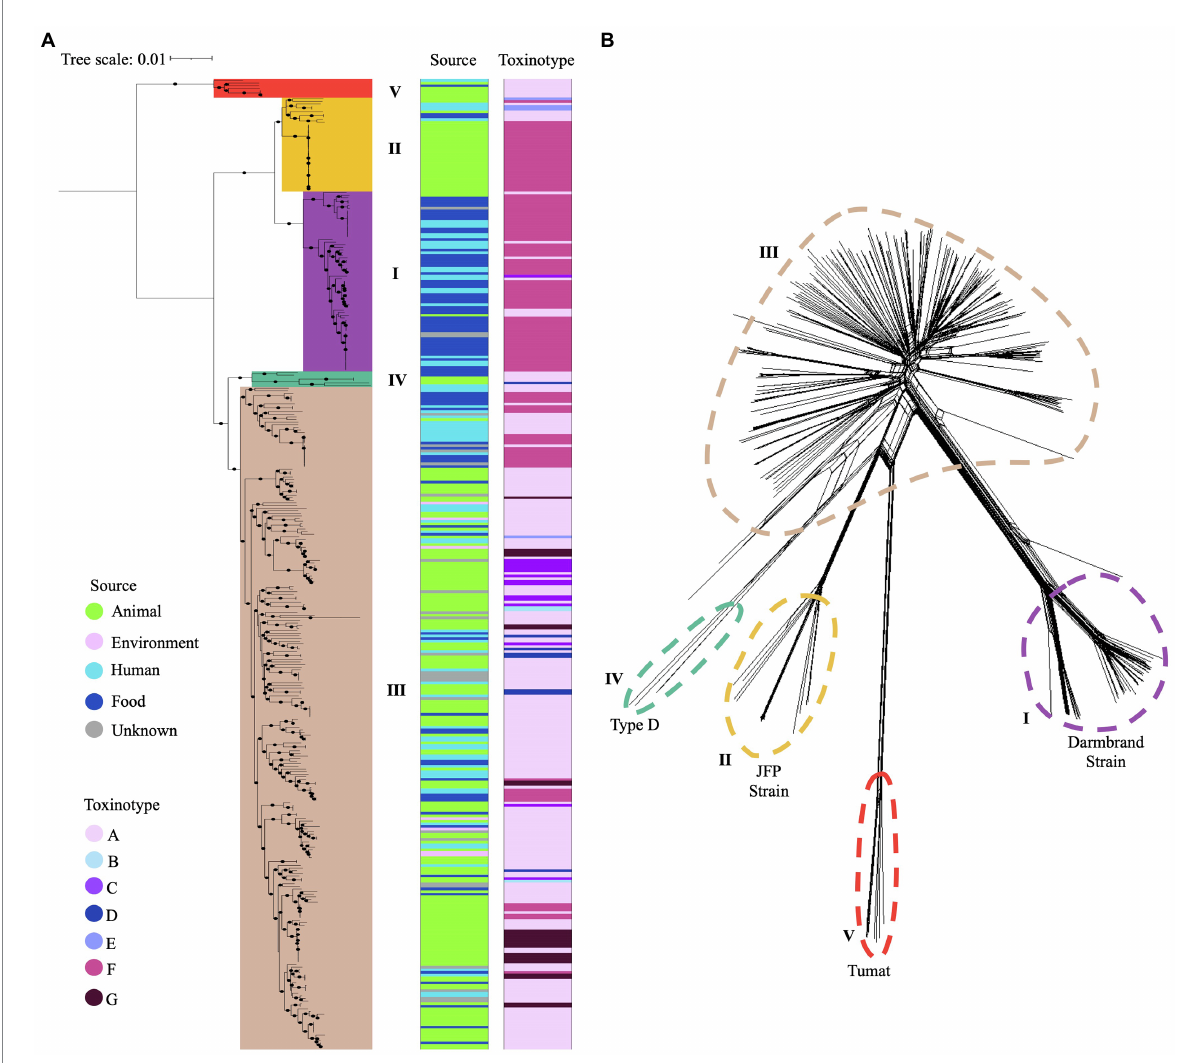
FIGURE 3 Phylogenetic grouping of C. perfringens using two different approaches. (A) Phylogenetic tree based on the core genome of 372 genomes. Five main phylogroups are highlighted in different colors. Source type and toxinotype are shown on the right panels. (B) Five phylogenetic networks based on the Neighbor-Joining (NJ) algorithm are shown with different